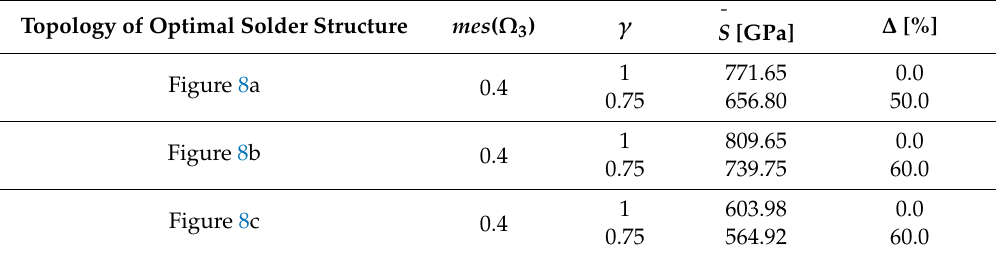
Table 3. Optimal graded microstructures of the solder distribution.